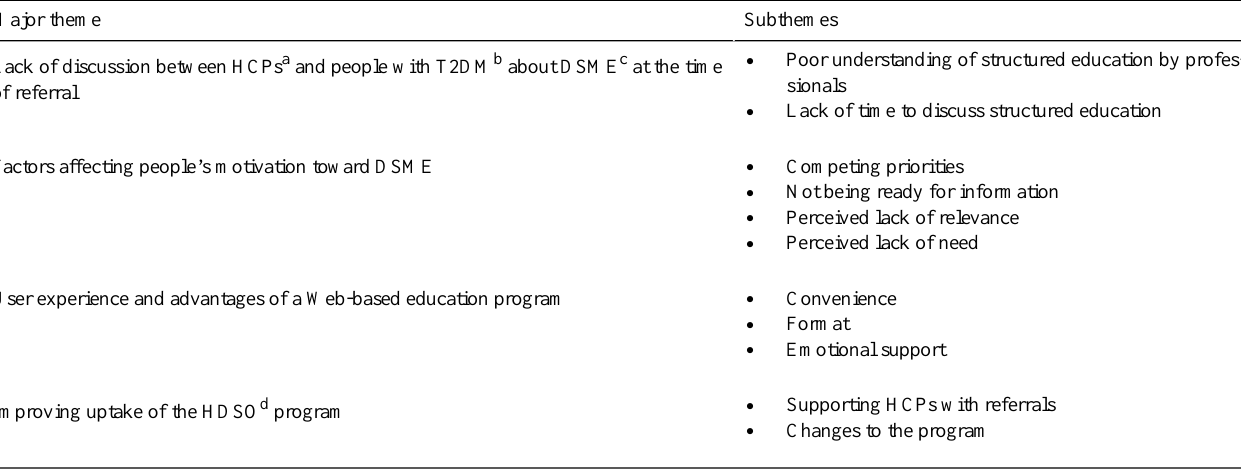
Table 5. Major themes and subthemes from the qualitative data.